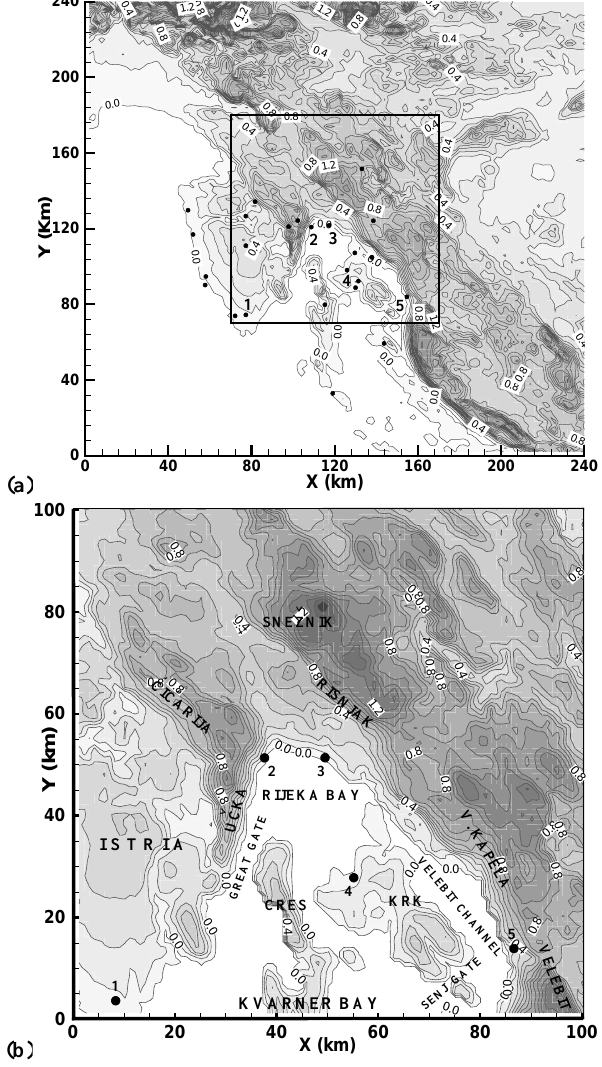
Fig. 1. Outer model domain (a) and inner model domain (b) also indicated by the square in (a). 1=Pula-airport ( φ =44 ◦ 54 0 N, λ =13 ◦ 55 0 E); 2=Opatija ( φ =45 ◦ 20 0 N, λ =14 ◦ 19 0 E), 3=Rijeka ( φ =45 ◦ 20 0 N, λ =14 ◦ 27 0 E), 4=Malinska ( φ =45 ◦ 7 0 N, λ =14 ◦ 32 0 E) and 5=Senj ( φ =45 ◦ 0 0 N, λ =14 ◦ 54 0 E). Additional black dots in (a) represent other meteorological and cli- matological stations located in the area. Topography contours are plotted every 100m between at 0m and 1700m. The contours of 0m, 400m, 800m and 1200m are labeled as 0.0, 0.4, 0.8, 1.2, re- spectively. See text for geographical details.